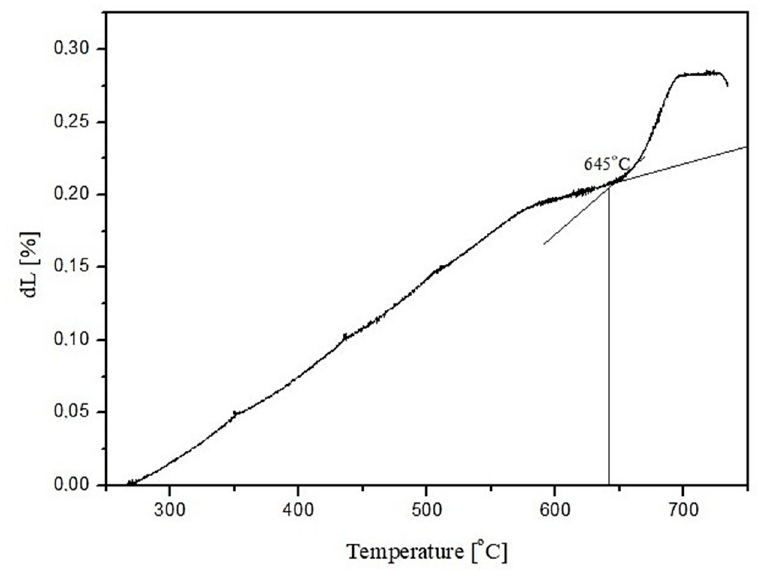
Figure 7. Dilatometric curve of 100 wt.% amphibolite glass (Set 1*).